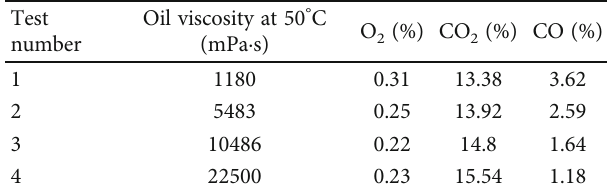
Table 5: Average gas components in the stable combustion